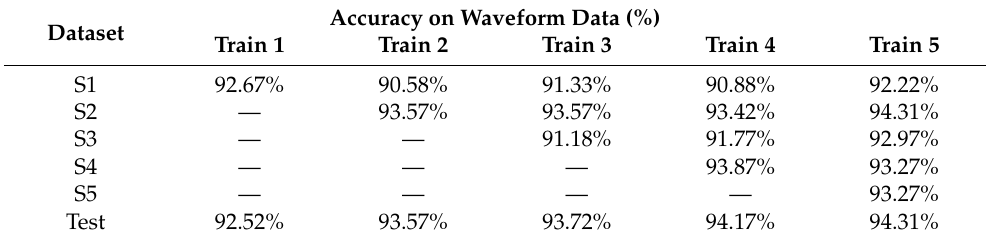
Table 8. Result of ISVM_DD waveform